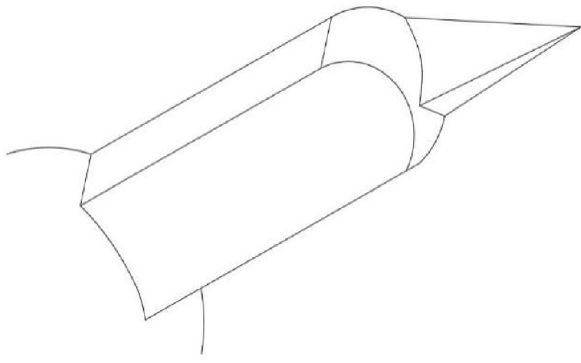
Figure 13. Schematic diagram of combined tank